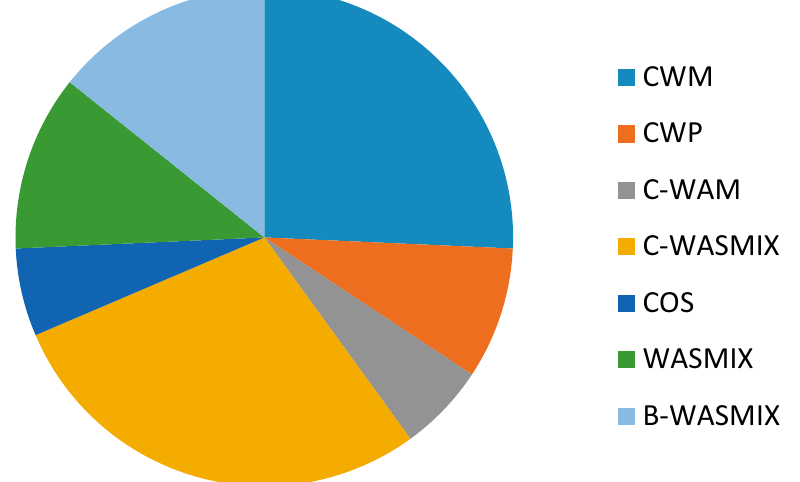
Figure 2. Distribution of slurry fuels used in the reviewed investigations.